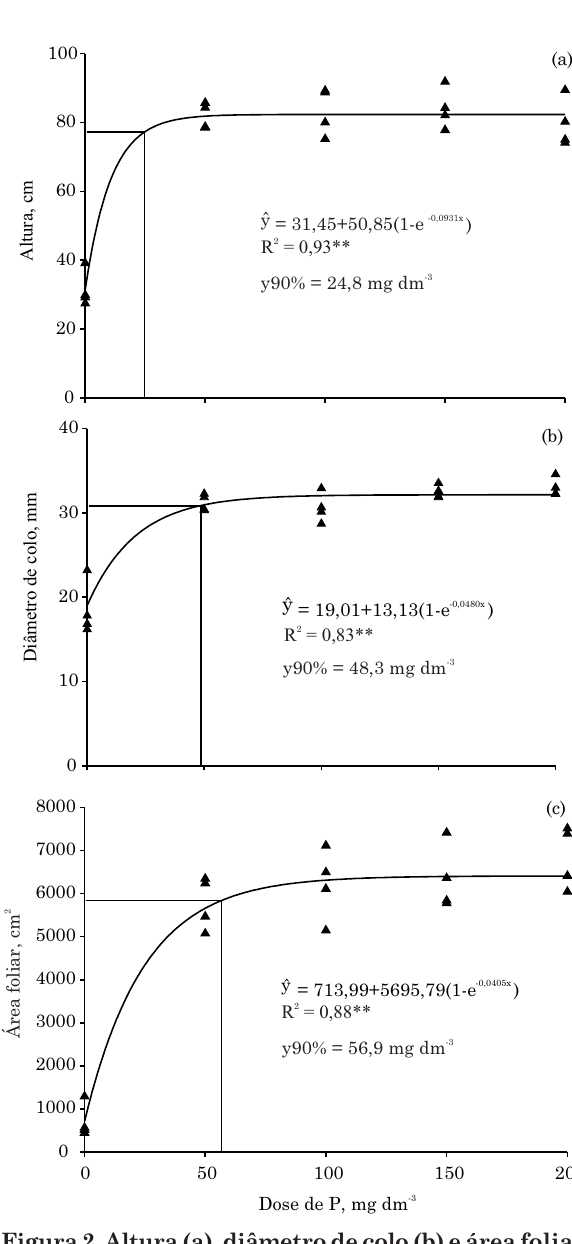
(Figura 3d). O acúmulo de todos os nutrientes ajustou- se a modelos exponenciais (Quadro 2), e os valores,